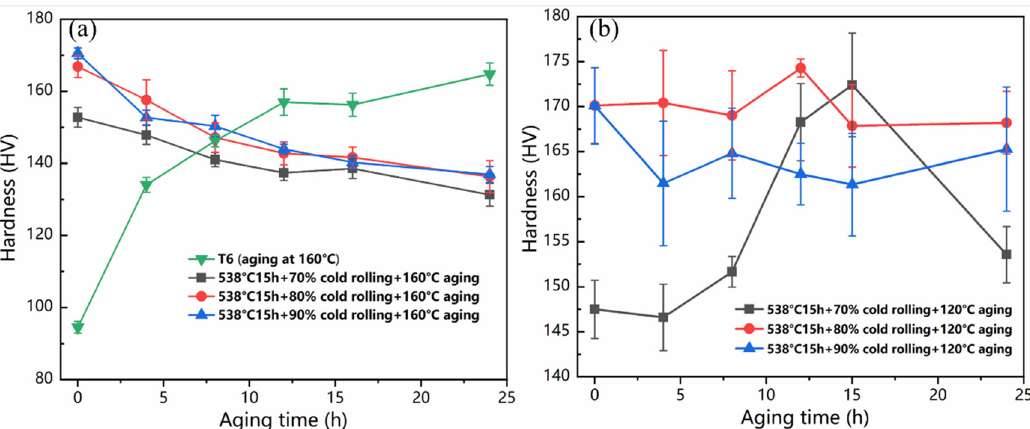
Figure 1. Variation of Vickers hardness during aging for samples subjected to ( a ): T6 and aging at 160 °C after 70–90% cold rolling and ( b ) aging at 120 °C after 70–90% cold rolling.